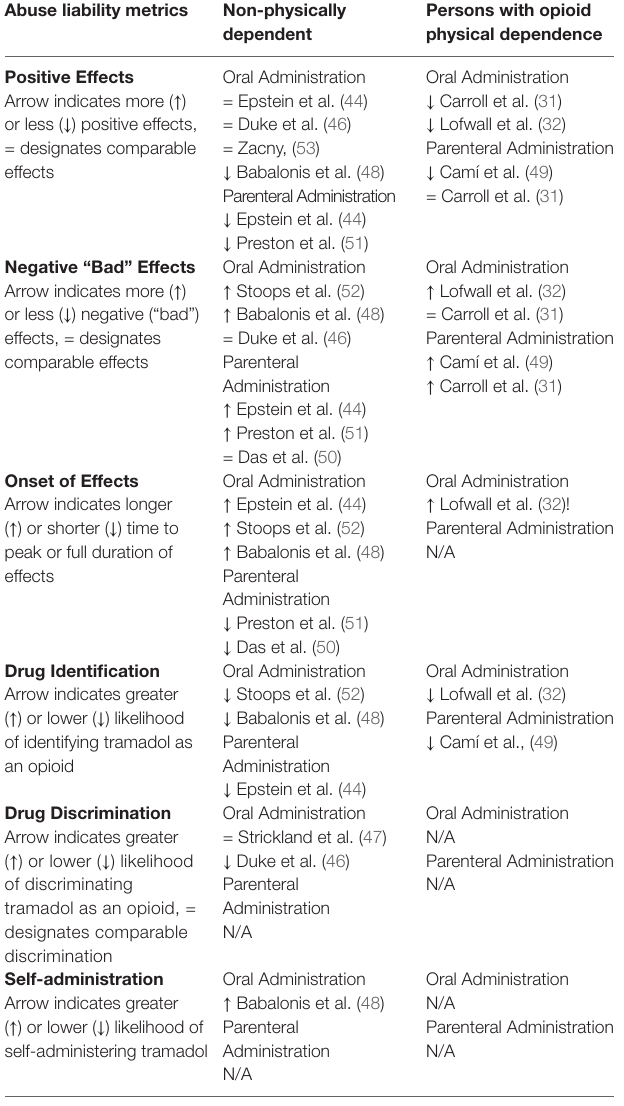
TABLE 2 | Summary of Abuse Liability of Tramadol Relative to Opioid